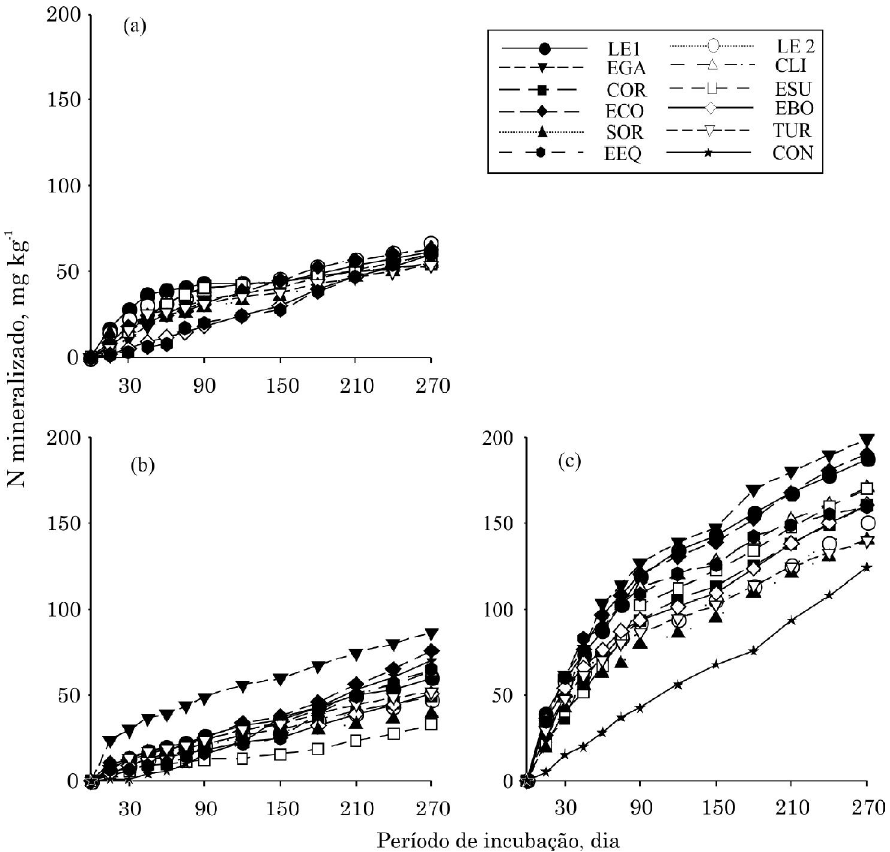
Figura 1. Mineralização acumulada de N dos resíduos orgânicos incubados com (a) areia lavada, (b) Latossolo Vermelho-Amarelo e (c) Latossolo Vermelho distroférrico, até os 270 dias de incubação. LE 1: lodo de esgoto 1; LE 2: lodo de esgoto 2; EGA: esterco de galinha; CLI: composto de lixo; COR: composto orgânico; ESU: esterco de suíno; ECO: esterco de codorna; EBO: esterco de bovino; SOR: substrato orgânico; TUR: turfa; EEQ: esterco de equino; e CON: controle (sem adição de